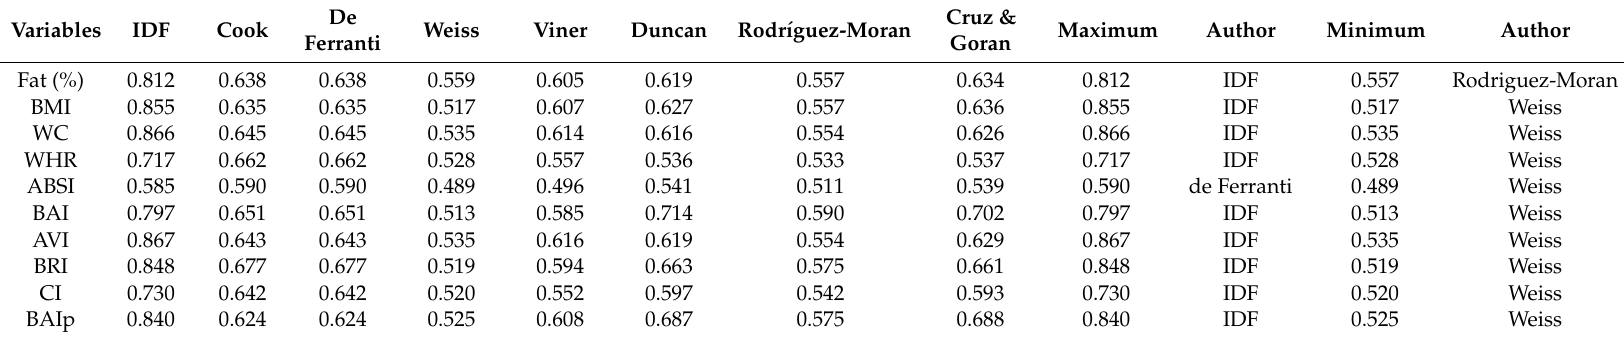
Table 6. Area under the curve (AUC) in receiver-operator curve (ROC) analysis of di ff erent anthropometric indexes for predicting MetS components in girls according to diagnostic